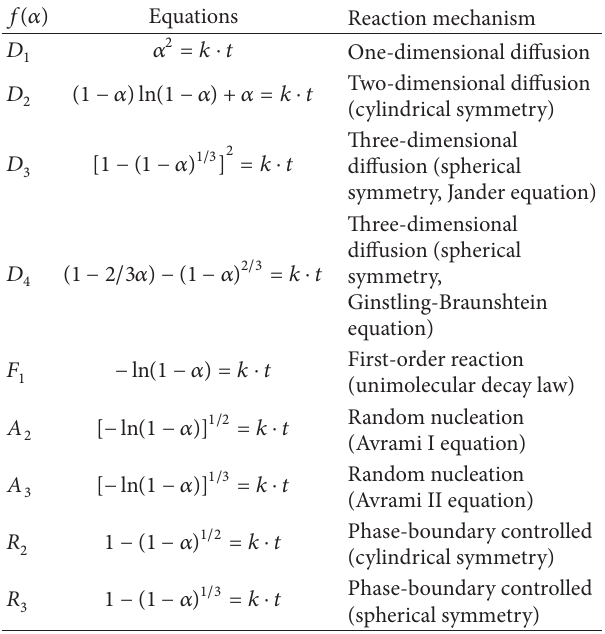
Table 1: Reaction mechanisms and the corresponding